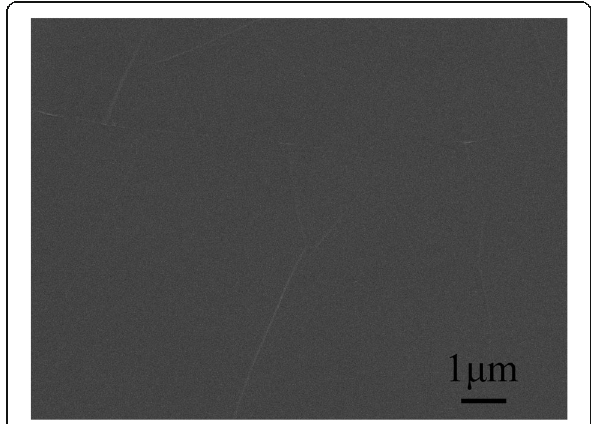
Fig. 4 FE-SEM images of nucleation layers grown at 1000 °C